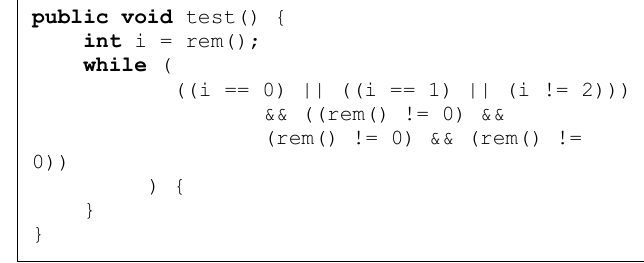
Fig. 12. Decompiled method without System.gc() calls.